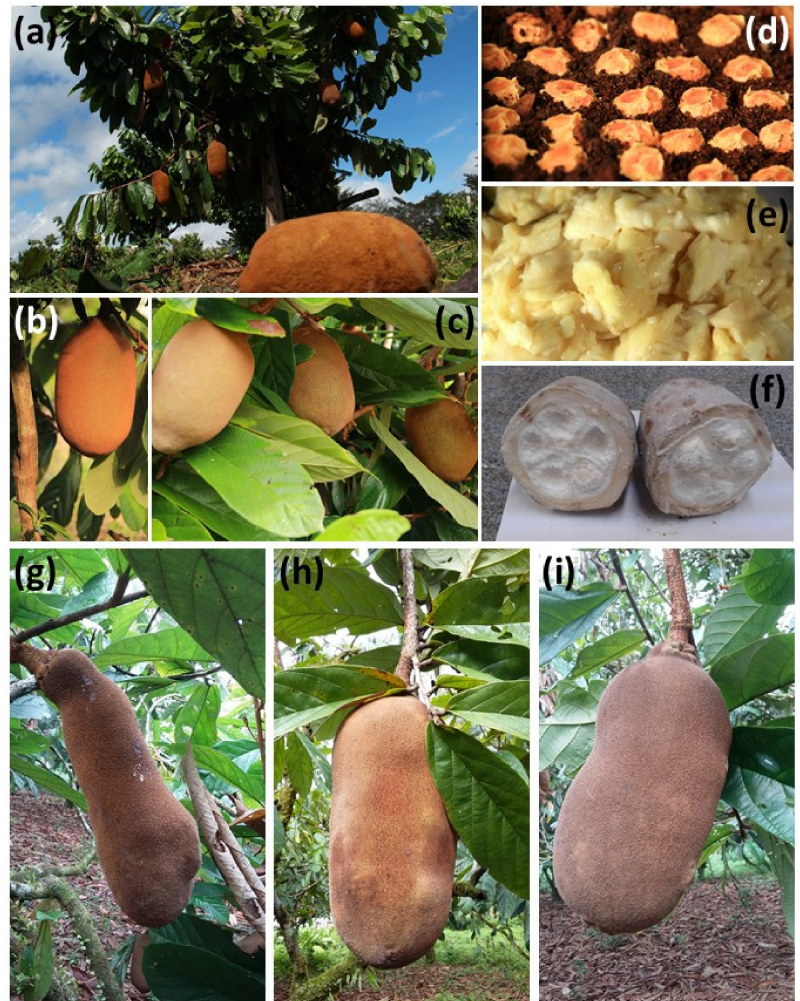
Figure 1. Cupuassu plant material used in this study. ( a ) General view of the cupuassu orchard from EMBRAPA Amaz ô nia Oriental (PA, Brazil); ( b ) mature fruit from the 1074 genotype (susceptible to witches’ broom disease); ( c ) mature fruit from the 174 genotype (resistant to witches’ broom disease); ( d ) cupuassu seeds (in the sowing); ( e ) fresh cupuassu pulp (after separation from the seeds); ( f ) frozen cupuassu fruit with pulp and seeds; ( g ) young fruit from the 1074 genotype; ( h ) matur- ing fruit from the 1074 genotype; and ( i ) mature fruit from the 1074 genotype. Photos: Ronaldo Rosas